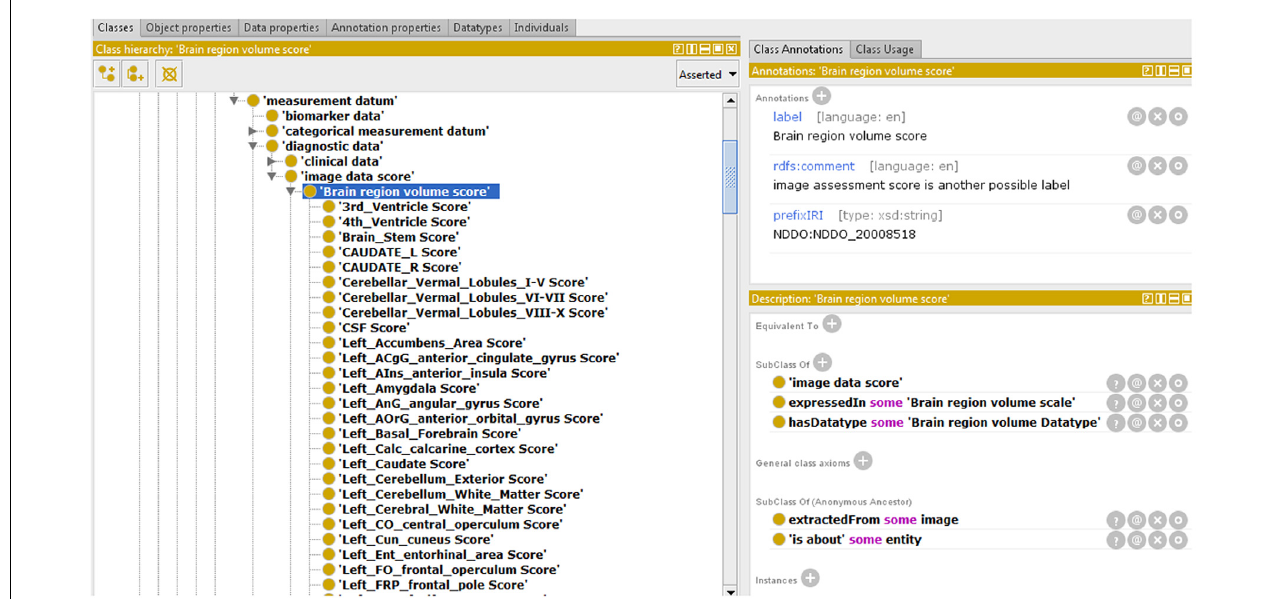
FIGURE 5 | Partial view of an Neurodegenerative Disease Data Ontology (NDDO) module integrated with NIO.